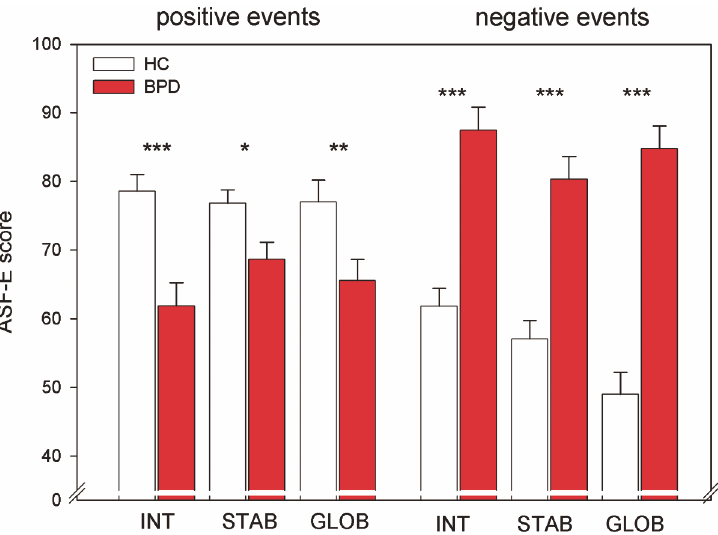
Figure 2. Altered attributional style in Borderline Personality Disorder. ASF-E results on internality (INT), stability (STAB) and globality (GLOB) of attributions for positive and negative events in healthy controls (HC) and patients with Borderline Personality Disorder (BPD). ( * ) p < .10, p ** < .01, *** p <